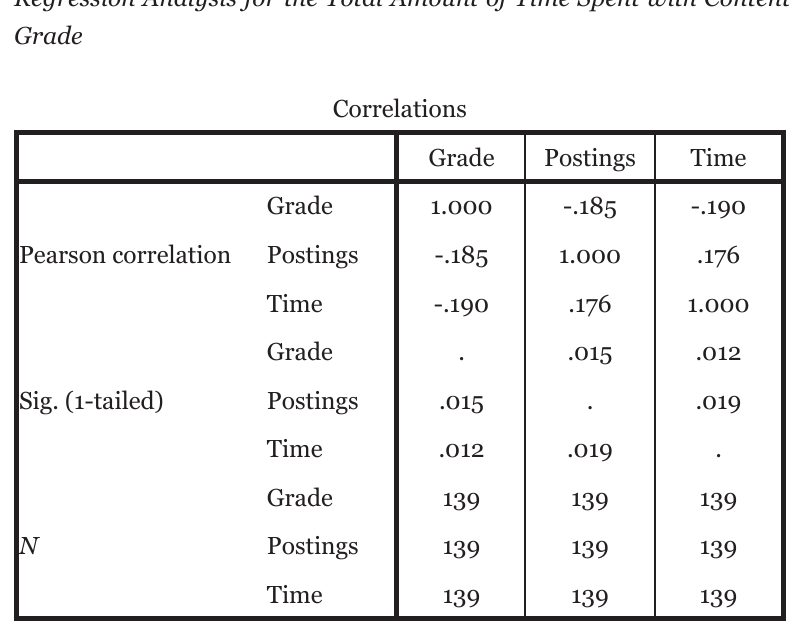
Regression Analysis for the Total Amount of Time Spent with Content and Final Course